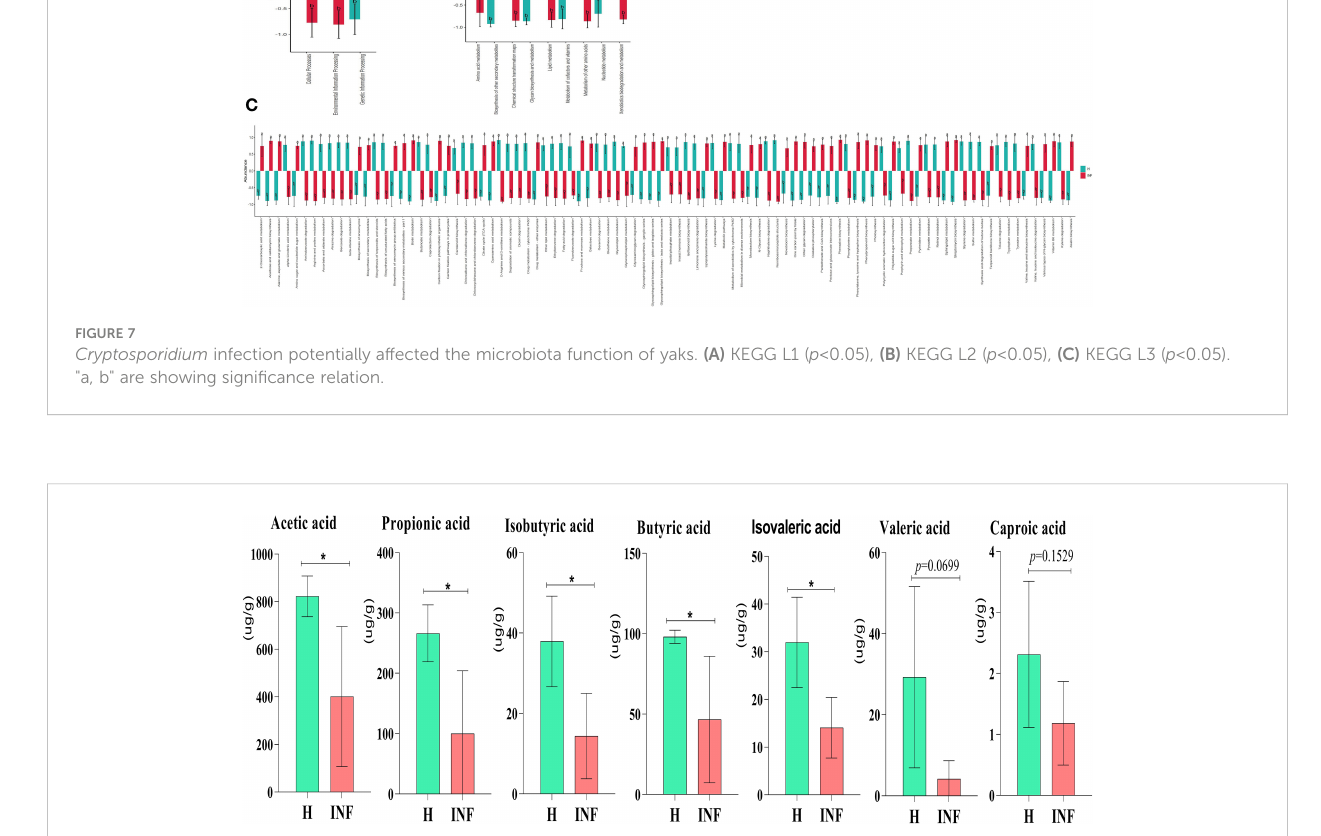
FIGURE 8 Concentration of SCFAs in yaks. Signi fi cance is presented as * p < 0.05; data are presented as the mean ± SEM (n =